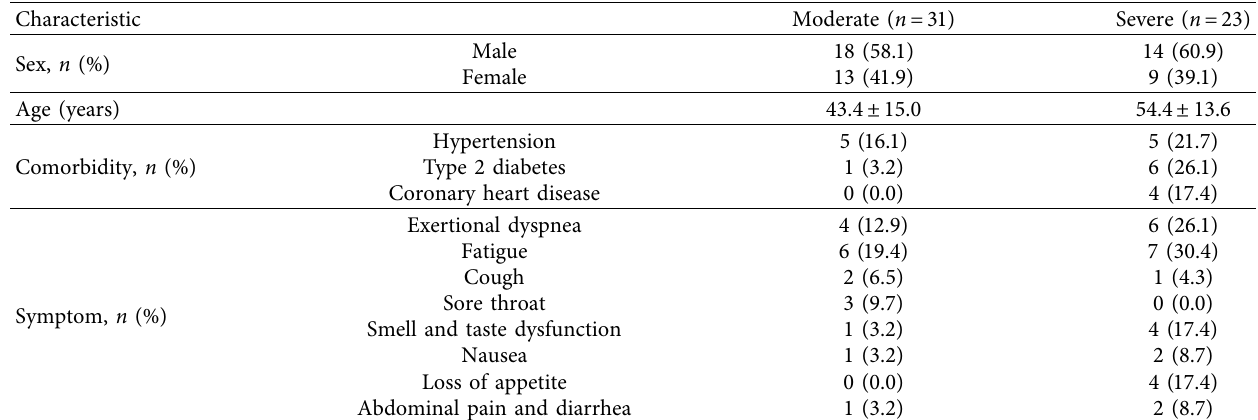
Table 2: Basic information and symptoms of the 54